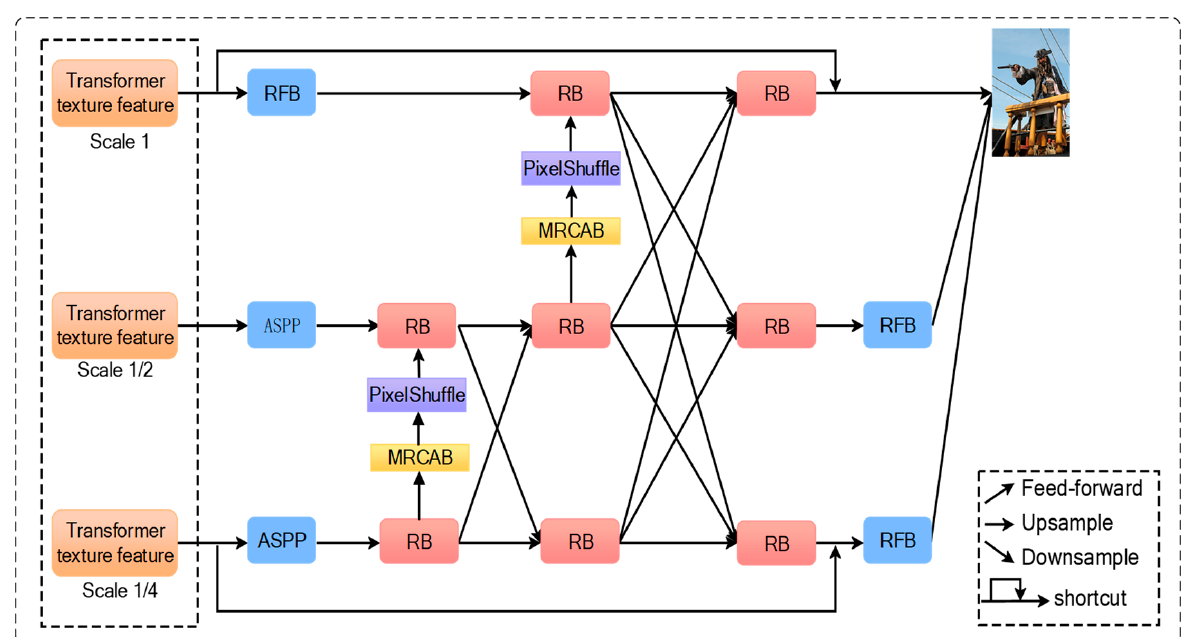
Figure 5. The architecture of the multi-scale feature integration process.